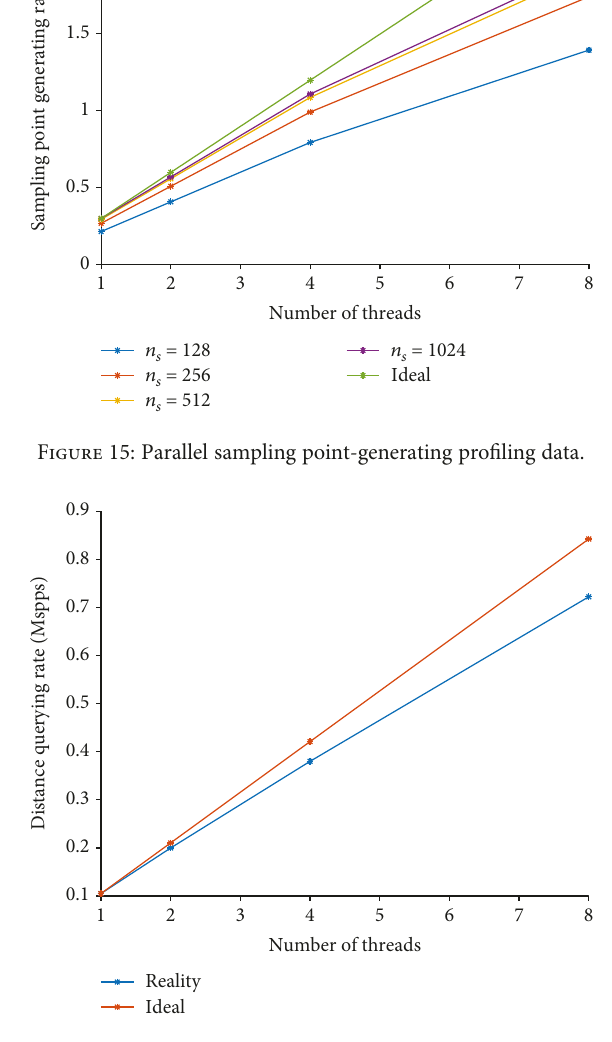
Figure 14: Serial sampling point-generating pro fi ling data.